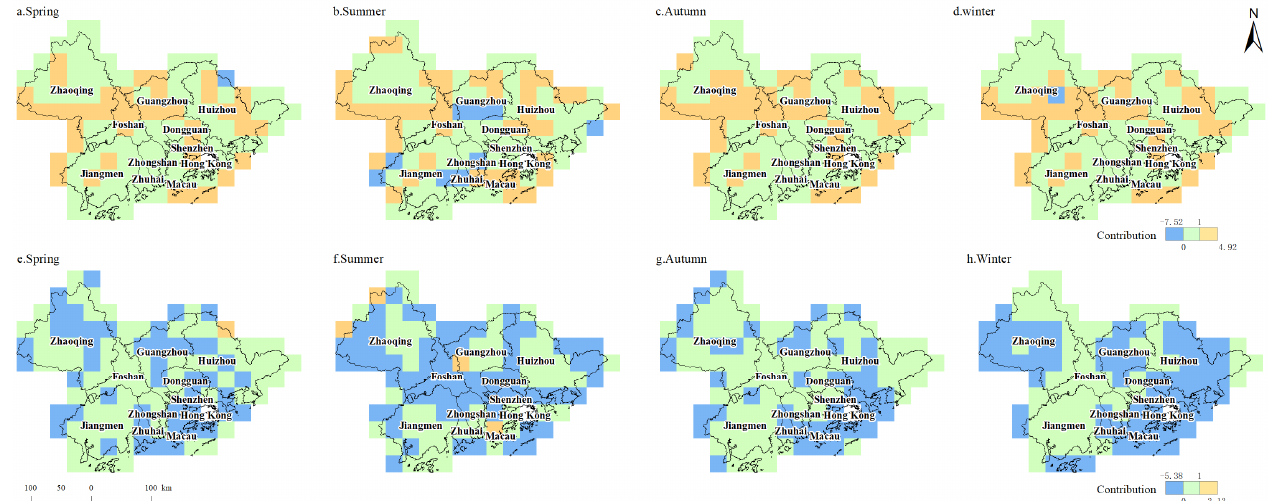
Figure 6. Distribution of the contribution degrees of seasonal meteorology and emission in the